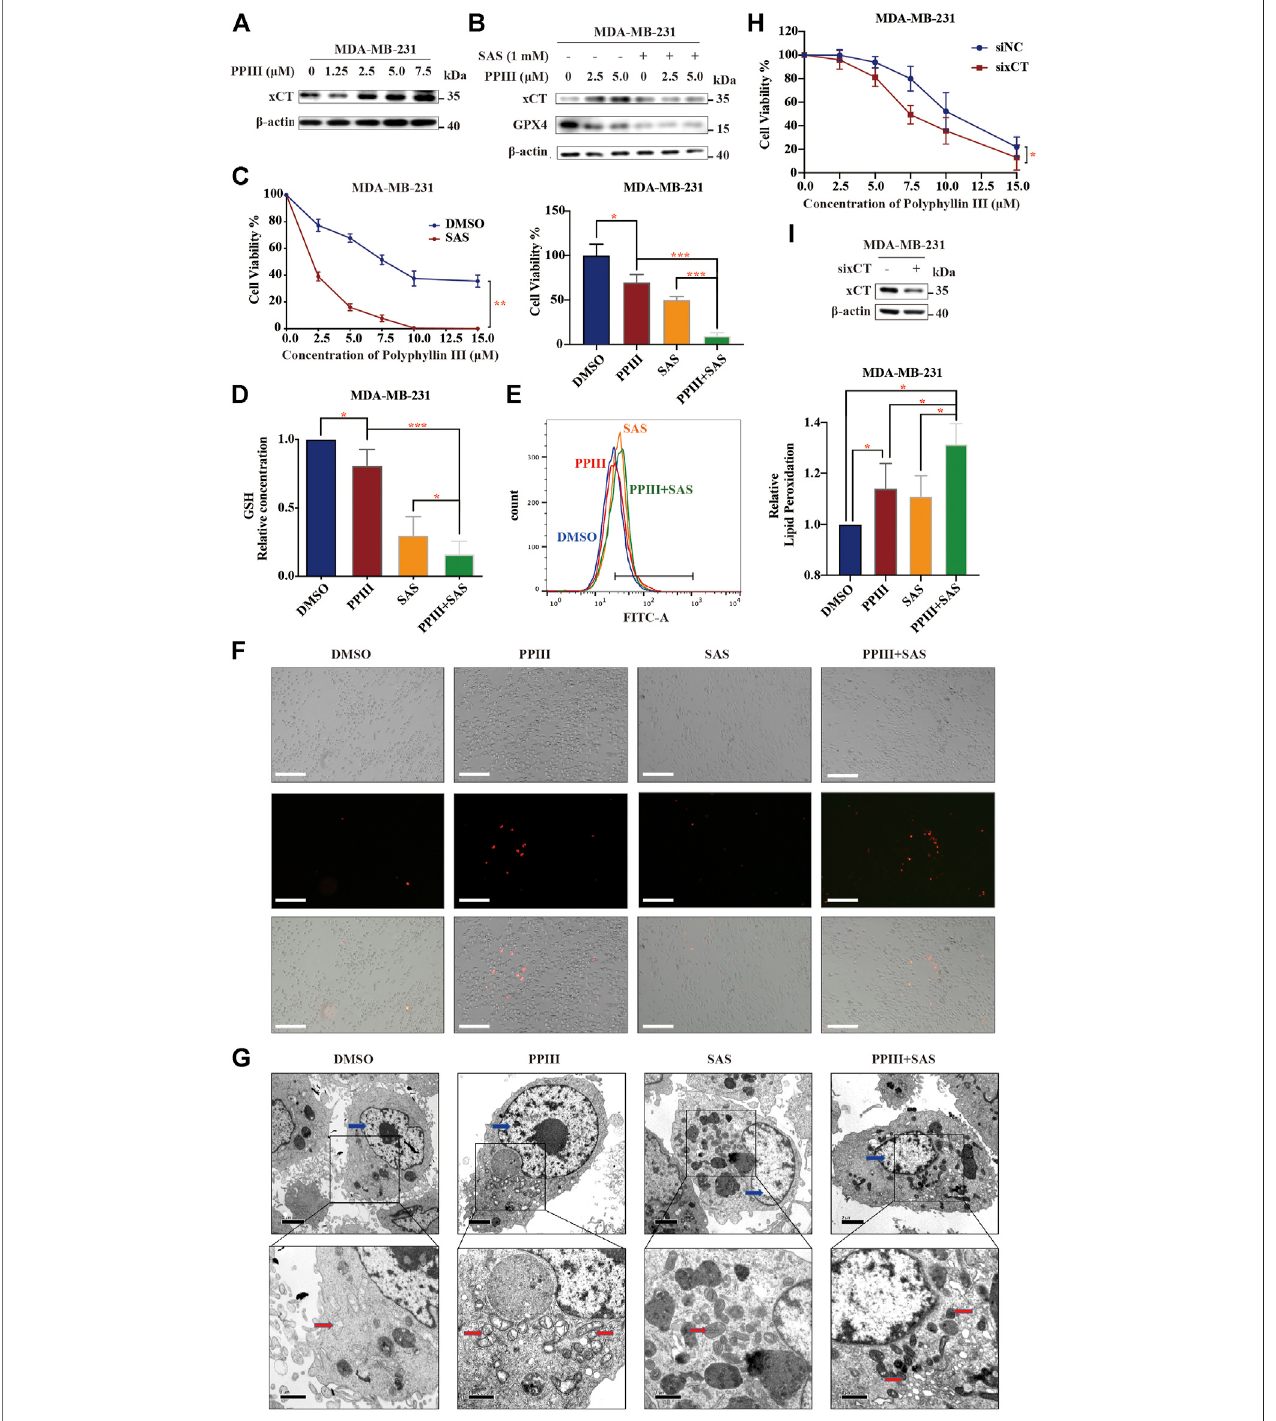
FIGURE3| PolyphyllinIIIinducesprotectivexCTupregulation,anditscombinationwithSASsensitizesbreastcancercellstoPolyphyllinIII. (A) .Westernblotanalysisof xCT expression in MDA-MB-231 cells after Polyphyllin III (0 – 7.5 μ M) treatment for 24 h. (B) . Western blot analysis of xCT and GPX4 expression in MDA-MB-231 cells after PolyphyllinIIItreatmentfor24 hwithorwithout1 mMSAS. (C – G) .MDA-MB-231cellsweretreatedwithPolyphyllinIII(0 – 15 μ M)for24 hintheabsenceorpresenceof1 mM SAS.Theerrorbarsshowthemeans ± SD, n (cid:2) 3independentrepeats,and p valueswerecalculatedusingatwo-tailedunpairedStudent ’ st-test(C)Thecellviabilitywas assayed(D)TherelativelevelsofGSHwereassayed(E)TherelativelevelsoflipidperoxidationwereassayedbyC11-BODIPY fl uorescence(F)Propidiumiodide(PI)stainingfor deadcells was conducted and observedunder fl uorescence microscopy(G)Transmissionelectronmicroscopyimageswere taken: red arrows, mitochondria; blue arrows, nucleus. (H) .MDA-MB-231cellsweretransfectedwithnegativecontrolsiRNA(siNC)orxCTsiRNA(sixCT)andthentreatedwith5 μ MPolyphyllinIIIfor24 h.Thecellviability was assayed ( n (cid:2) 3 independent repeats, p values were calculated using two-tailed paired Student ’ s t-test). (I) . Western blot analysis of xCT expression after sixCT transfection. * p < 0.05; ** p < 0.01; *** p < 0.001; n. s., not signi fi cant ( p > 0.05).